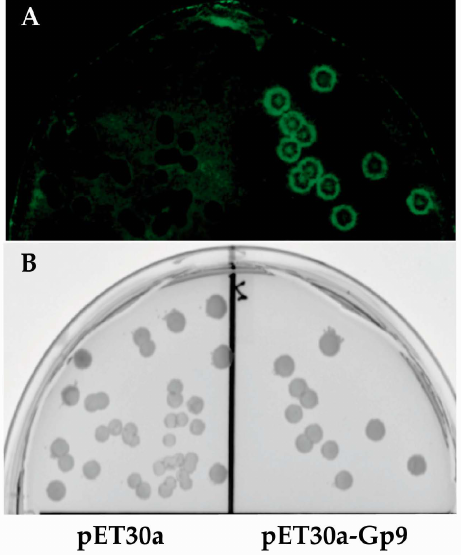
Figure 2. Image of colony lift. ( A ) Fluorescent image of Green Fluorescence Protein (GFP) expressing S. Typhimurium growing on a nitrocellulose membrane. ( B ) The corresponding master plate of the colony lift showing E. coli colonies from the empty vector control (pET30a) on the left and E. coli colonies expressing the positive insert (16155–19050) from the assay on the right.